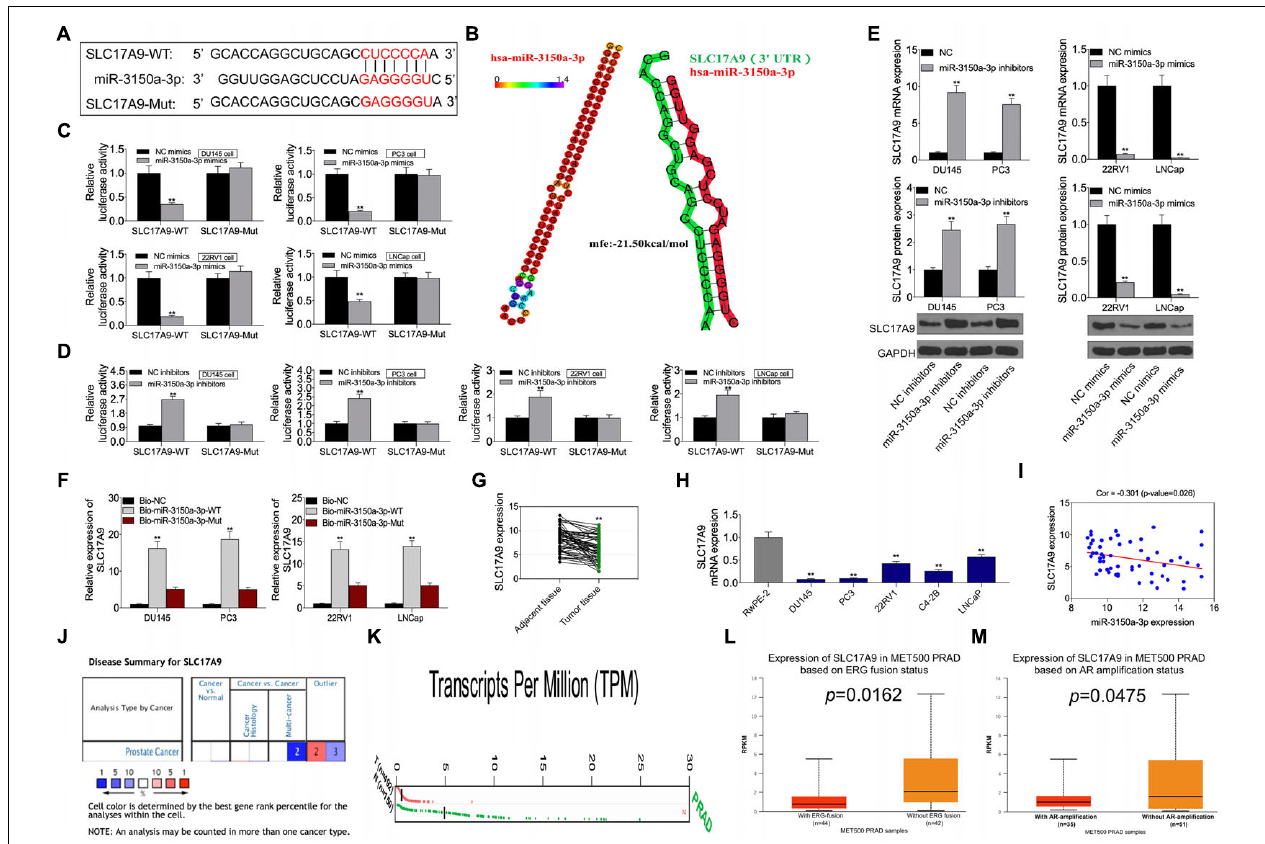
FIGURE 7 | (A) SLC17A9 acted as a target gene of miR-3150a-3p in PCa. SLC17A9 was predicted as a potential target of miR-3150a-3p by the starBase website. (B) The stem-loop structure of hsa-miR-3150a-3p was displayed using the RNAhybrid program, and the SLC17A9 target binding sites on the whole miR-3150a-3p sequences were predicted. (C,D) Binding of SLC17A9 to miR-3150a-3p verified by dual-luciferase reporter gene assay. (E) miR-3150a-3p expression in PCa cell lines transfected with miR-3150a-3p mimics or inhibitors determined by qRT-PCR and WB assays. (F) Dramatic enrichment of SLC17A9 was detected